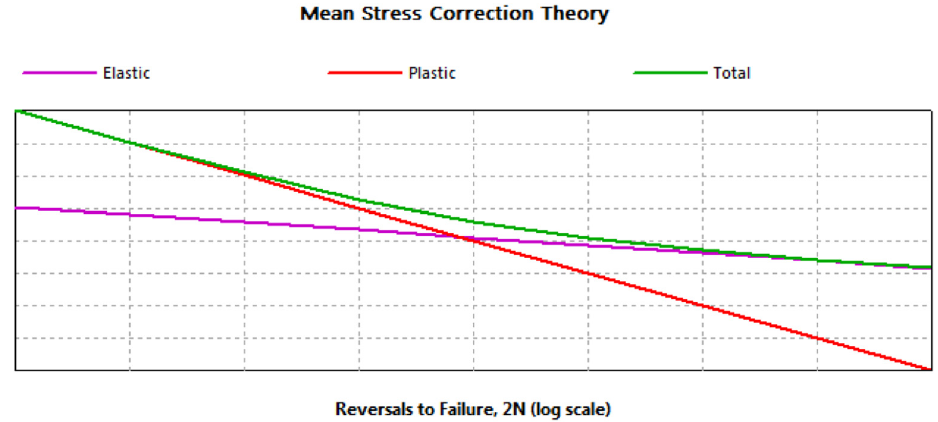
Fig. 6. Strain-life